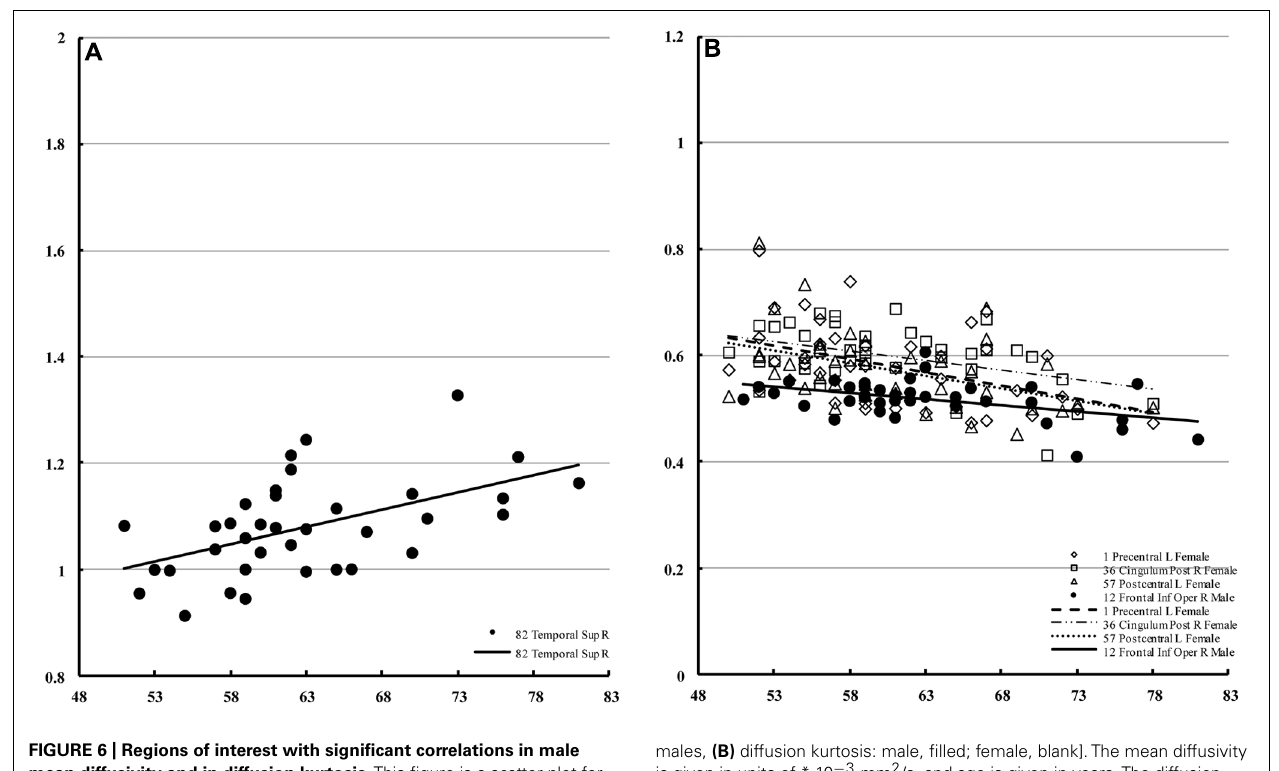
males, (B) diffusion kurtosis: male, filled; female, blank].The mean diffusivity is given in units of * 10 − 3 mm 2 /s, and age is given in years.The diffusion kurtosis has no dimension.